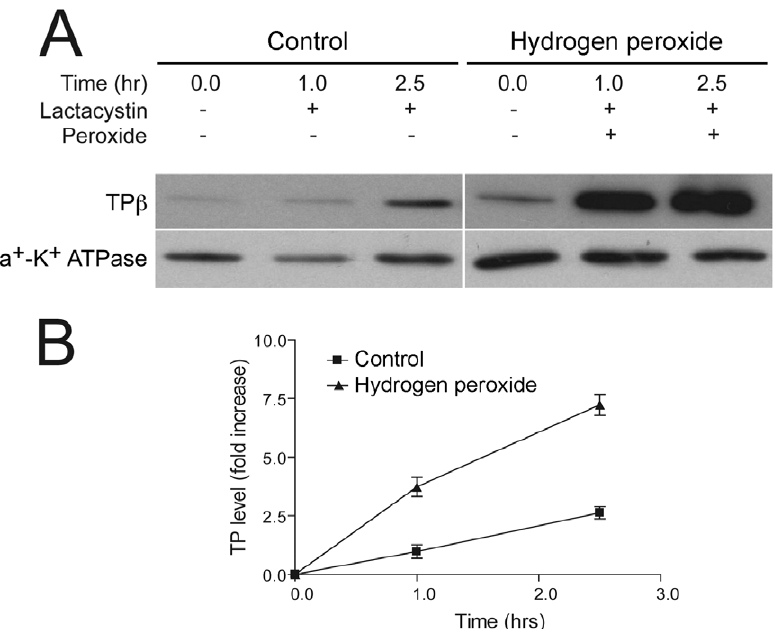
Figure 6. Turnover of TP b and control of cell-surface expression requires proteasomal function. Inhibition of the proteasome in HEK293 cells stably expressing HA-TP b was achieved by incubating the cultures with lactacystin (1 m M) and cycloheximide (30 m M) both in the absence and presence of H 2 O 2 (Panel A). At times 0, 1 and 2.5 hours, cell-surface HA-TP b was labelled with a water-soluble biotin analogue and bound to streptavidin beads. Recovered HA-TP b was probed by Western blotting with anti-HA antibodies. Quantified data (Panel B), normalized to control cells suggest that the proteasome plays a role in the negative regulation of cell-surface HA-TP b during oxidative stress. Data are representative of the means 6 SEM of three independent experiments where the presence of hydrogen peroxide caused a significant increase in HA-TP b (P , 0.05) at 2.5 hours (*) compared to the non-H 2 O 2 group.